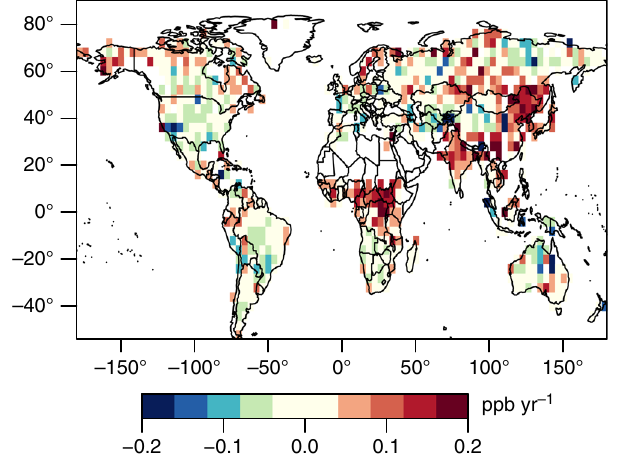
gure only displays boxes with more than 250 total observations.